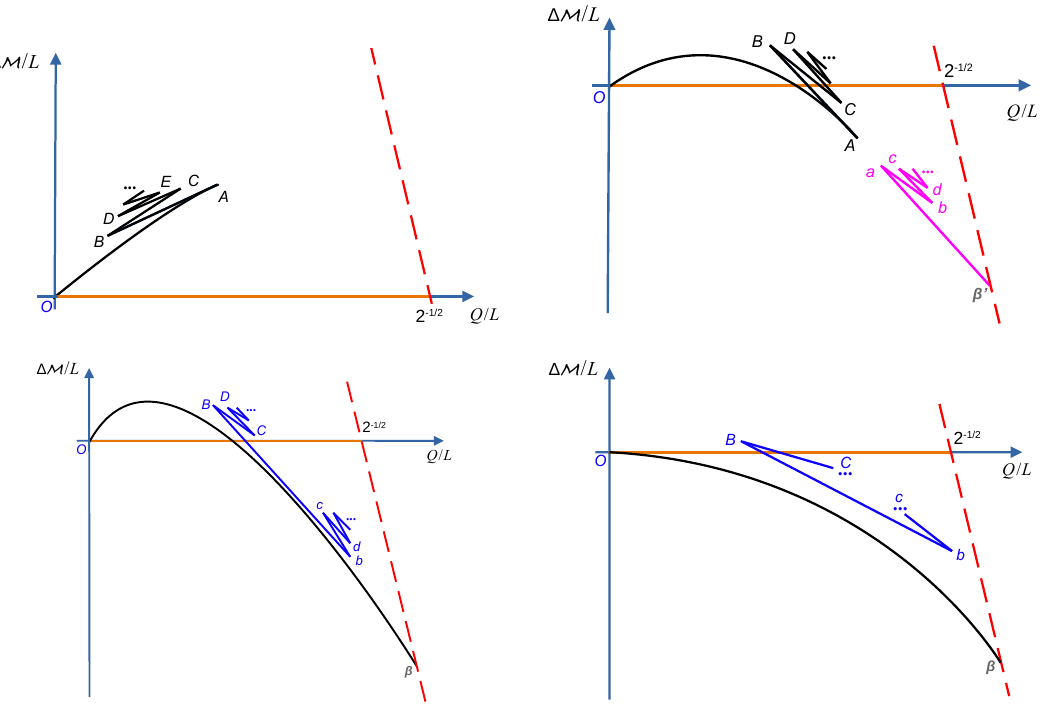
Figure 1 . Sketch of the quasilocal phase diagram for solitons as we span relevant windows of scalar field charge e . The critical charges are such that 0 < e < e c < e . The quantity ∆ M NH S is the quasilocal mass difference between the soliton and an extremal RN BH that has the same quasilocal charge Q /L . Hence the orange line at ∆ M = 0 describes the extremal RN solution that must have Q /L ≤ 2 − 1 / 2 to fit inside the box. The red dashed line represents the maximal quasilocal charge of solutions that can fit inside the box. It intersects the extremal RN line at Q /L = 2 − 1 / 2 . Non-extremal RN BHs confined in the box have ∆ M > 0 and fill the triangular region bounded by Q = 0 and by the orange and red dashed lines. The main soliton family is always given by black curves that start at O . The secondary soliton family is given either by magenta or blue curves. Top-left panel: case e < e γ . Top-right panel: case e γ < e < e c . Bottom-left panel: case e c < e < e . S Bottom-right panel: case e > e S